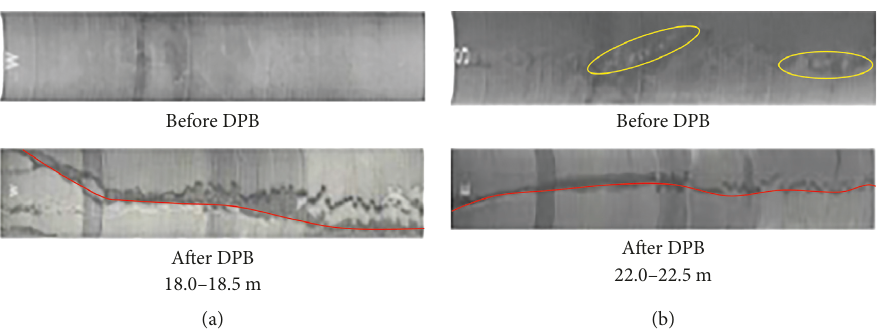
F IGURE 21: Fracture variation along the holes axis before and after blasting. (a) 18.0–18.5m. (b) 22.0–22.5m.